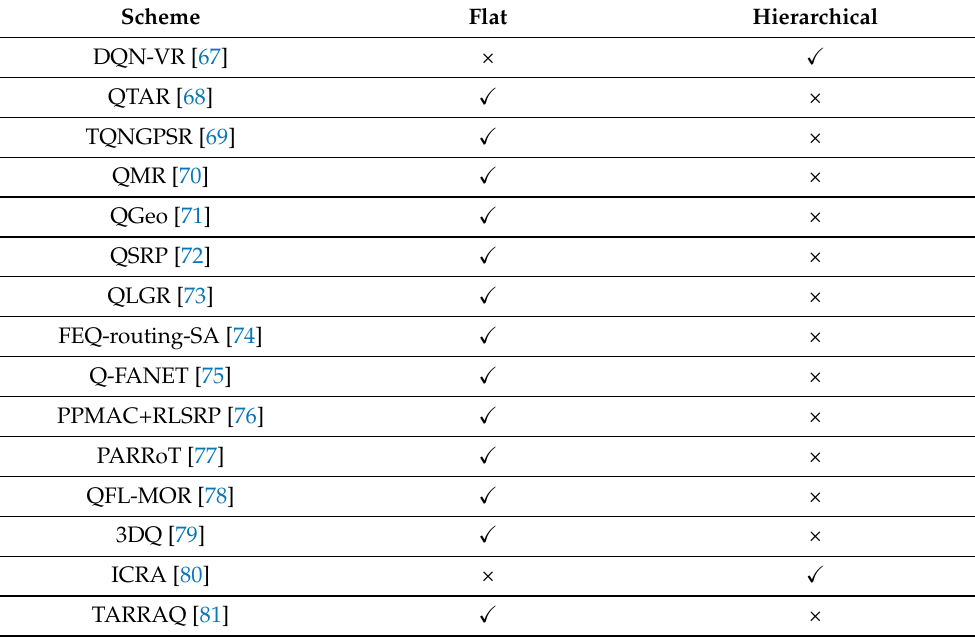
Table 29. Comparison of RL-based routing methods based on network topology. Scheme Flat